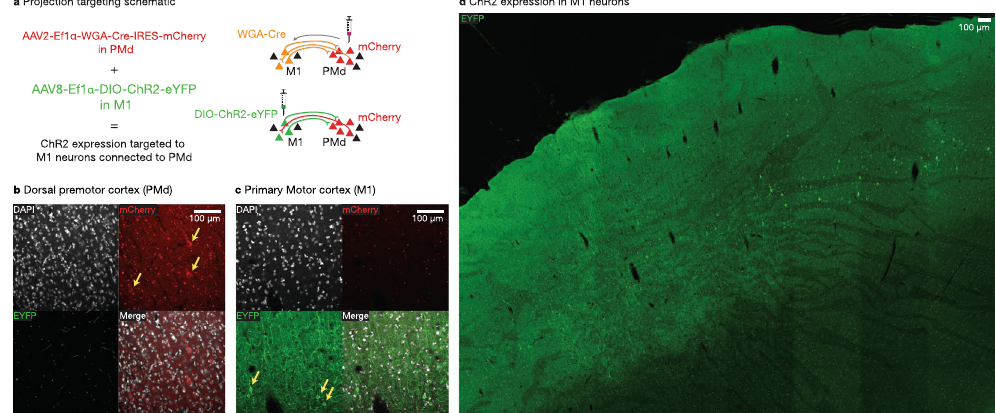
Figure 4. WGA-Cre enables targeting projections for circuit-specific neural modulation. ( a ) Schematic illustrating injection of AAV2-Ef1 α -mCherry-IRES-WGA-Cre in PMd and AAV8-Ef1 α -DIO-ChR2(H134R)- EYFP in M1 in order to target M1 cells that are connected to PMd. ( b ) Right PMd cell bodies expressing mCherry and projecting fibers expressing ChR2(H134R)-EYFP in Sq. I. ( c ) Right M1 cell bodies highlighted with yellow arrows expressing ChR2(H134R)-EYFP in Sq. I. ( d ) Large overview image of EYFP-ChR2(H134R) expressing neurons in